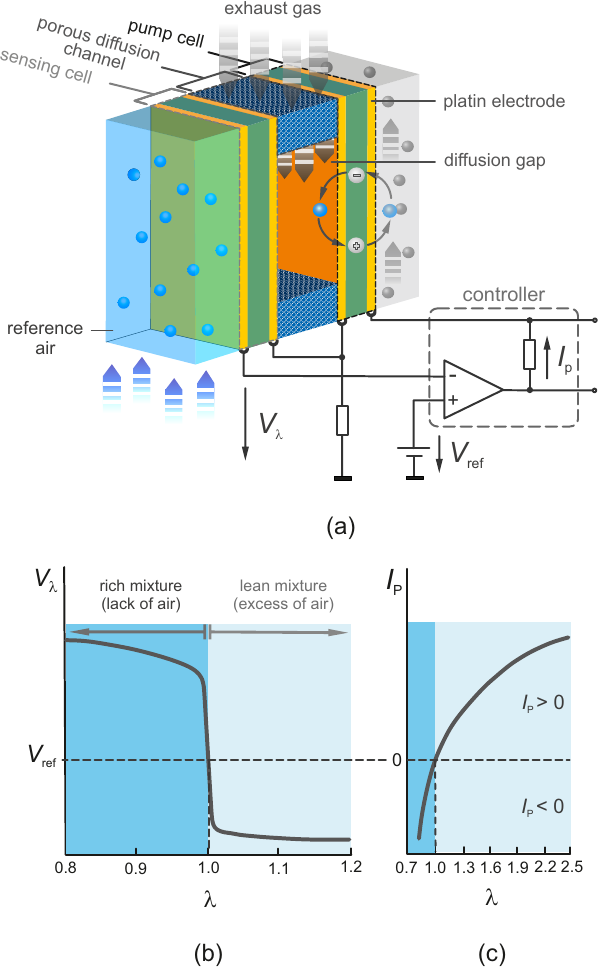
Figure 5. (a) Schematic illustration of the core section of a broad- band lambda probe including the feedback control circuit, accord- ing to NGK (2012) (for the sake of simplicity, the heater neces- sary to heat up the probe to the optimal working temperature is not shown in this illustration); general illustration of the transfer char- acteristics of a conventional (b) and a broadband lambda probe (c) according to Bosch GmbH (2010).